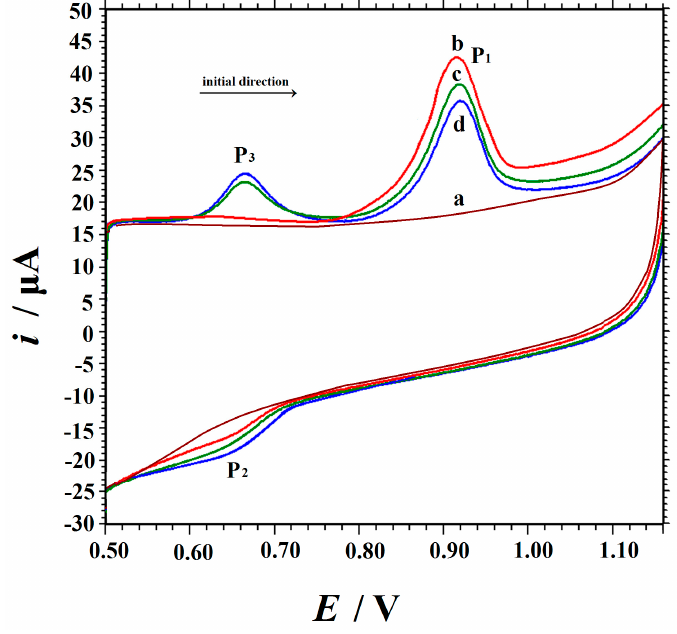
Figure 4. Cyclic voltammetry (CV) curves obtained at Cu 2 O NPs-ERGO/GCE in the absence of vanillin (curve a ) and in the presence of 10 µ M vanillin in 0.1 M H 2 SO 4. (Curve b – d : continuous sweep cycles, b – d : 1st–3rd).